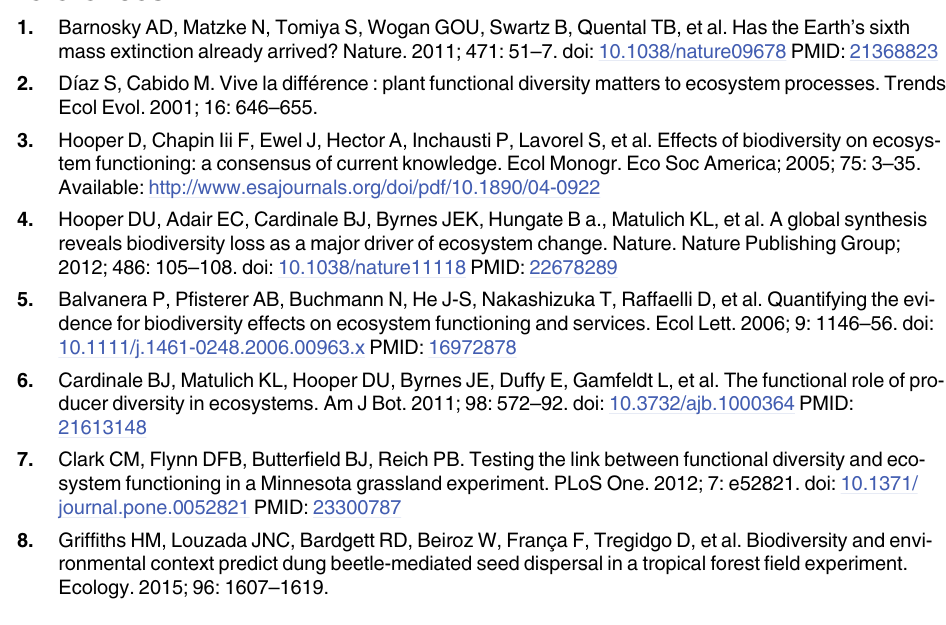
S1 Fig. Associations between raw